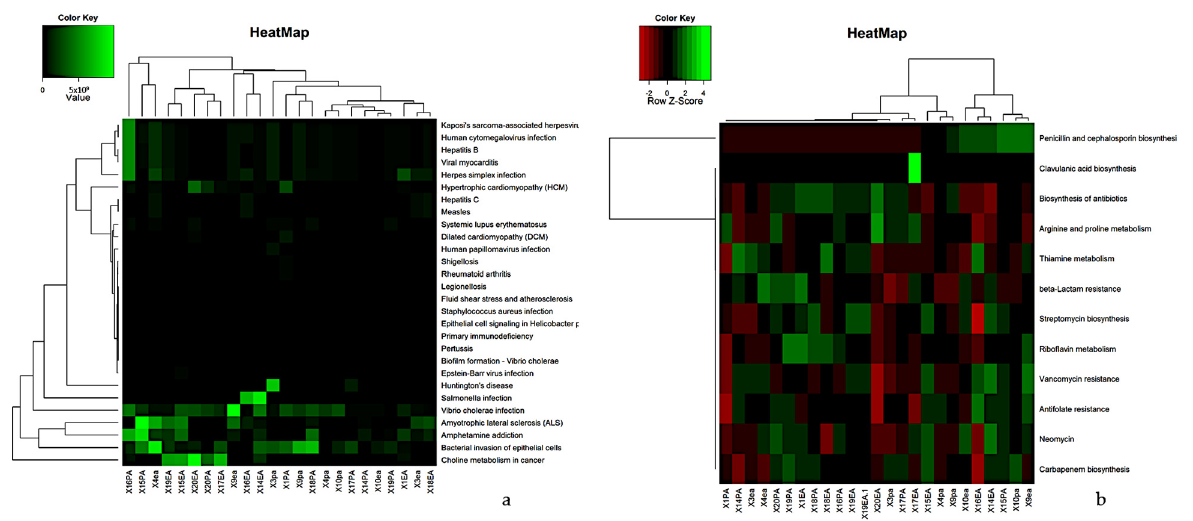
Figure 8. A hierarchical cluster heat map that shows the tax4Fun ( a ) functional prediction in metagenomes of the micro-bial community ( b ) Functional prediction study of health-related genes of 12 samples of RCs and PPs. The metabolic pathways (resulting from the prediction) are in the rows and the RCs and PPs samples are in the columns. Columns are centered on the mean, with relative abundance represented by colors (black and red, lowest abundance; green, highest abundance) as indicated in the